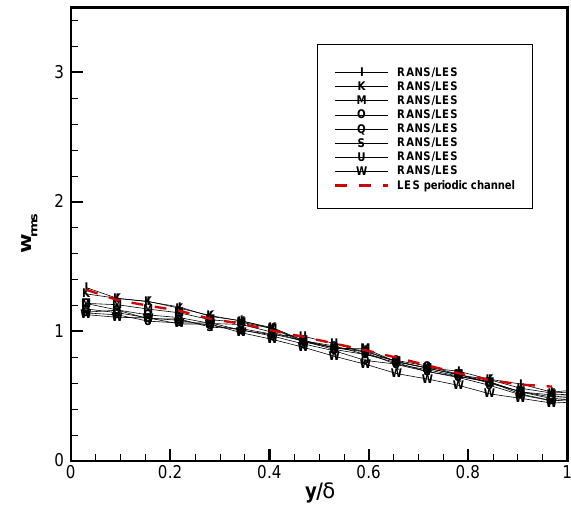
Fig. 7. Comparison of the wall normal rms profile. Red dashed line: reference results from the periodic channel simulation; black lines: wall-normal rms profile at different sections of the channel with the buffer region.